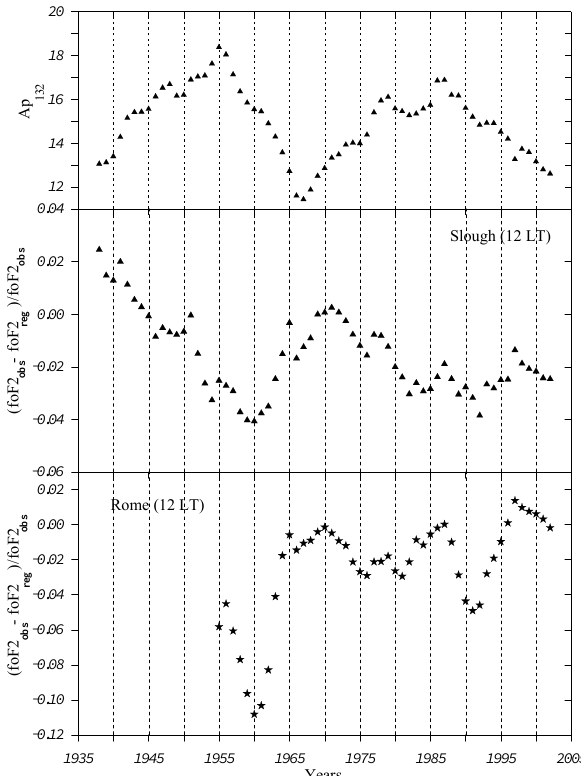
Figure 4 Fig. 4. 11-year running mean A p index, A p 132 (top panel) and observed δ fo F2 132 long-term variations at noon for Slough/Chilton and Rome stations. Note the geomagnetic control until 1997 and a “break down” of this control for the last available 5